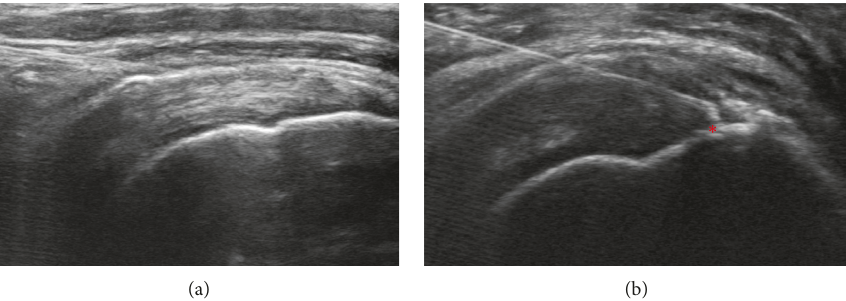
Figure 1: (a) Ultrasound-guided injection into (a) the subacromial bursa and (b) the supraspinatus tendon. ∗ The tear site of the supraspinatus